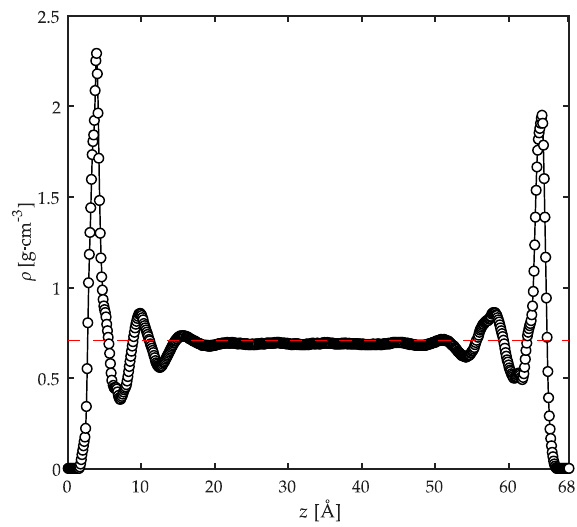
Figure 3. Local mass density profile, ρ , across the film thickness. The horizontal dashed line represents the mass density of the polymer from the bulk simulations. The results are calculated for the confined PP/Fe 2 O 3 system at 458 K and 1 atm.